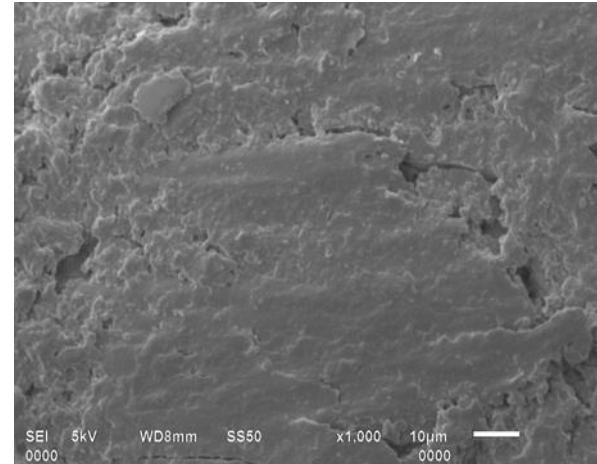
Figure 8: Scanning electron micrograph for (CY-230 + 10 wt% HY- 951+ 20 wt% treated Rice Husk (8% NaOH solution)